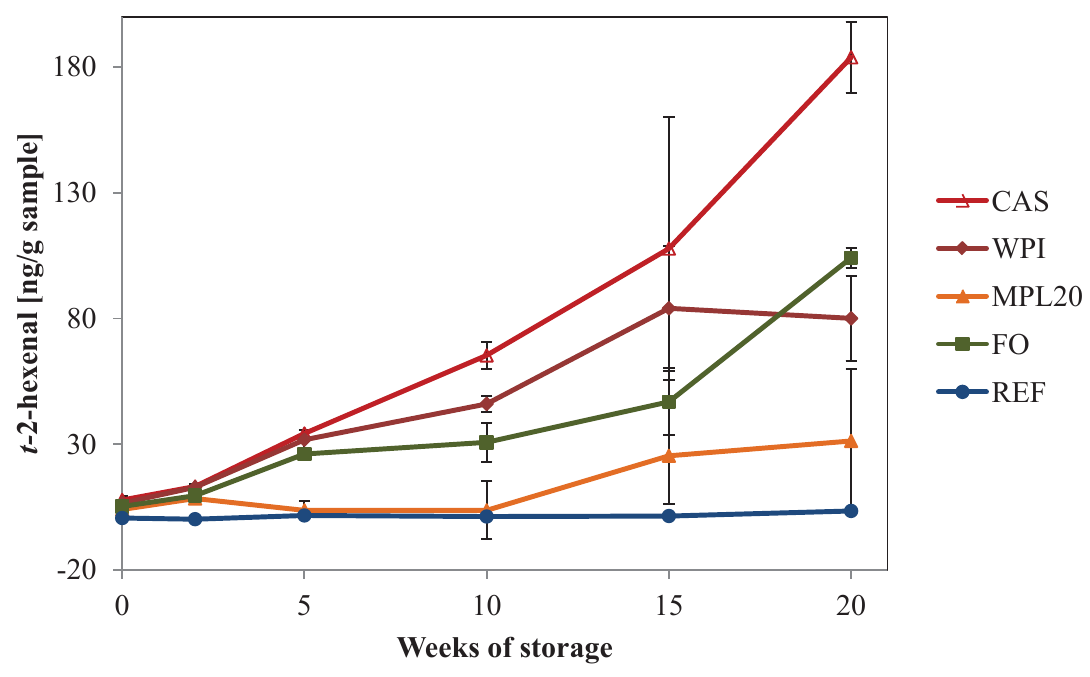
Figure 4. The development in t -2-hexenal (ng/g sample) in cream cheeses with fish oil added as neat oil (FO), or in a delivery emulsion prepared with different emulsifiers (CAS, WPI or MPL20) compared to a reference cheese without fish oil (REF) during storage for 20